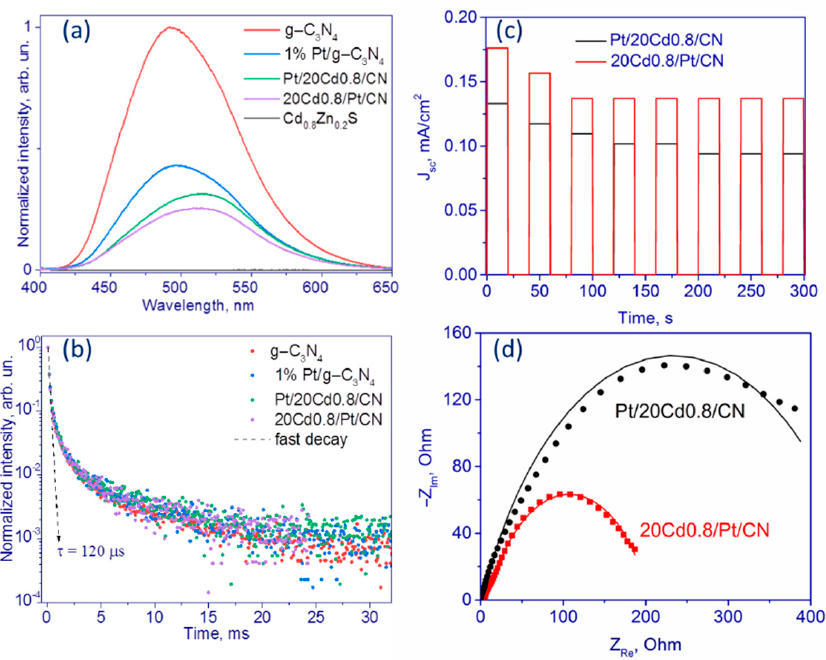
Figure 8. Normalized PL emission spectra of C 3 N 4 , 1% Pt/C 3 N 4 , Pt/20Cd0.8/CN, 20Cd0.8/Pt/CN, and Cd 0.8 Zn 0.2 S ( a ); normalized decay curves of PL intensities of the tested samples ( b ); photocurrent response ( c ); and EIS ( d ) of the samples Pt/20Cd0.8/CN (Scheme 1) and 20Cd0.8/Pt/CN (Scheme 2).